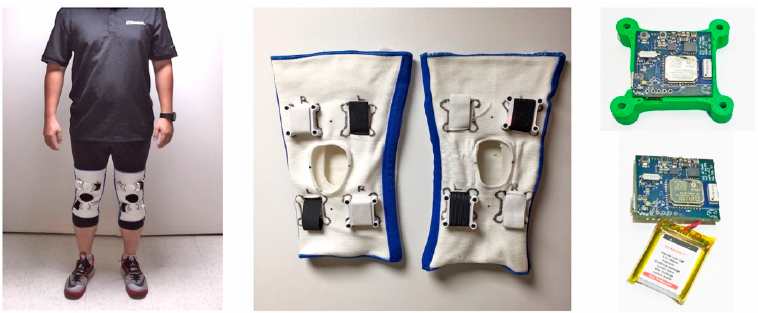
Figure 1. Depiction of MAPR system after donning by a subject ( left ); MAPR IMUs embedded in knee sleeves ( middle ); and circuit board of MAPR IMU ( right ).